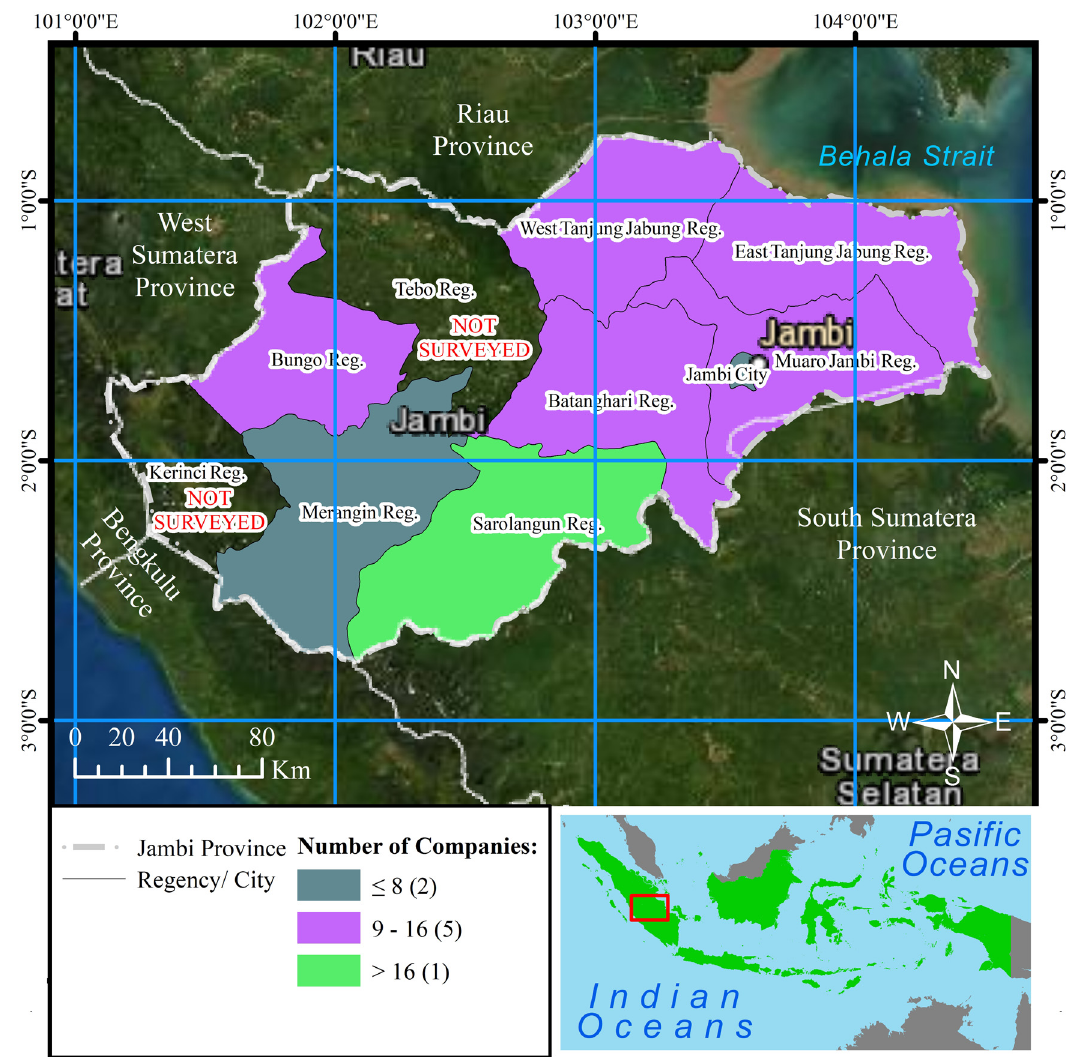
Figure 3: Research